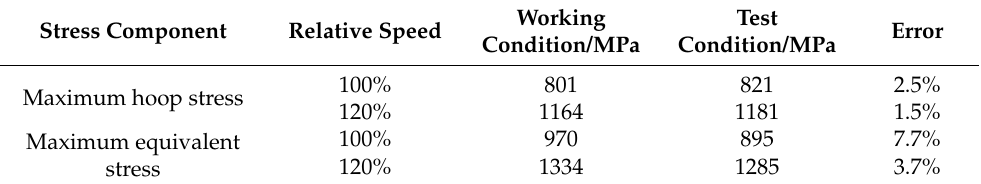
Table 2. Comparison of the maximum stress between the working condition and test condition.